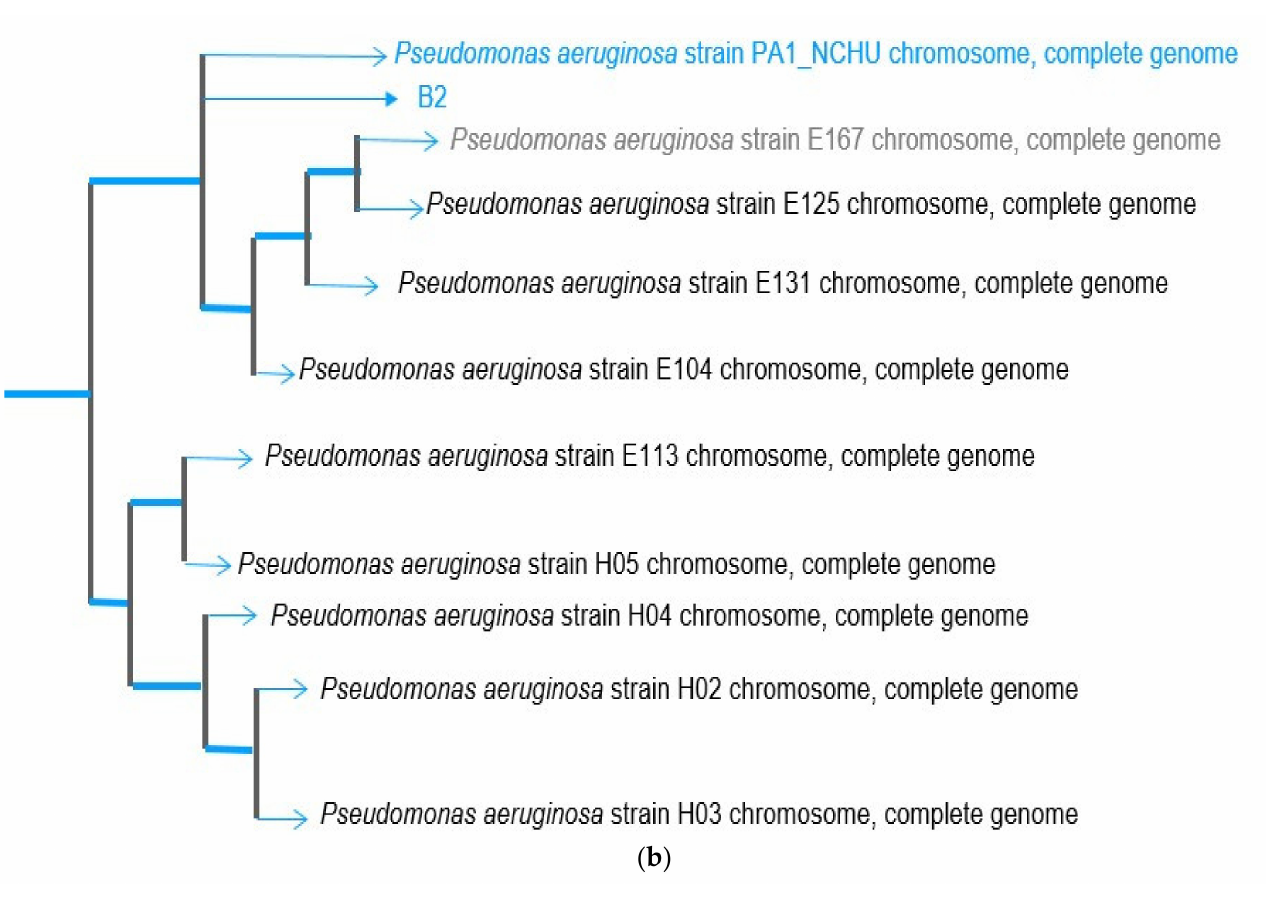
Figure 2. Phylogenetic tree of ( a ) Pseudomonas putida OsEnB_HZB_G20 strain; ( b ) Pseudomonas aeruginosa PA1_NCHU (Adapted from [33]) (Highlight and different colors of font represent microbial species of interest for this